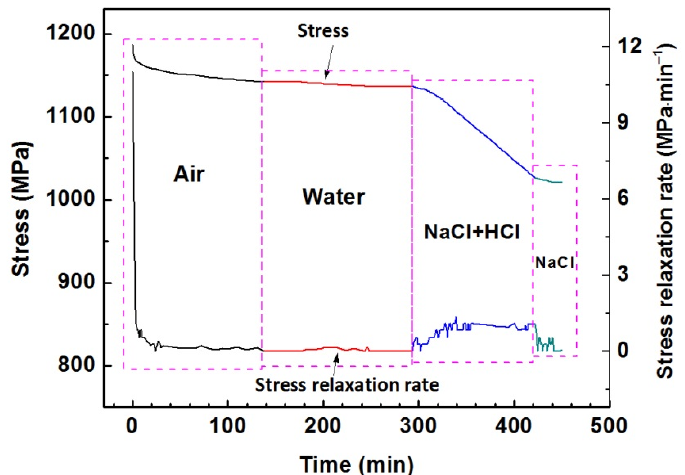
Figure 3. The variations of the stress and the relaxation rate versus time for FeSi6.5 steel sample in successive relaxation in air, water, HCl + NaCl solution, and NaCl solution.